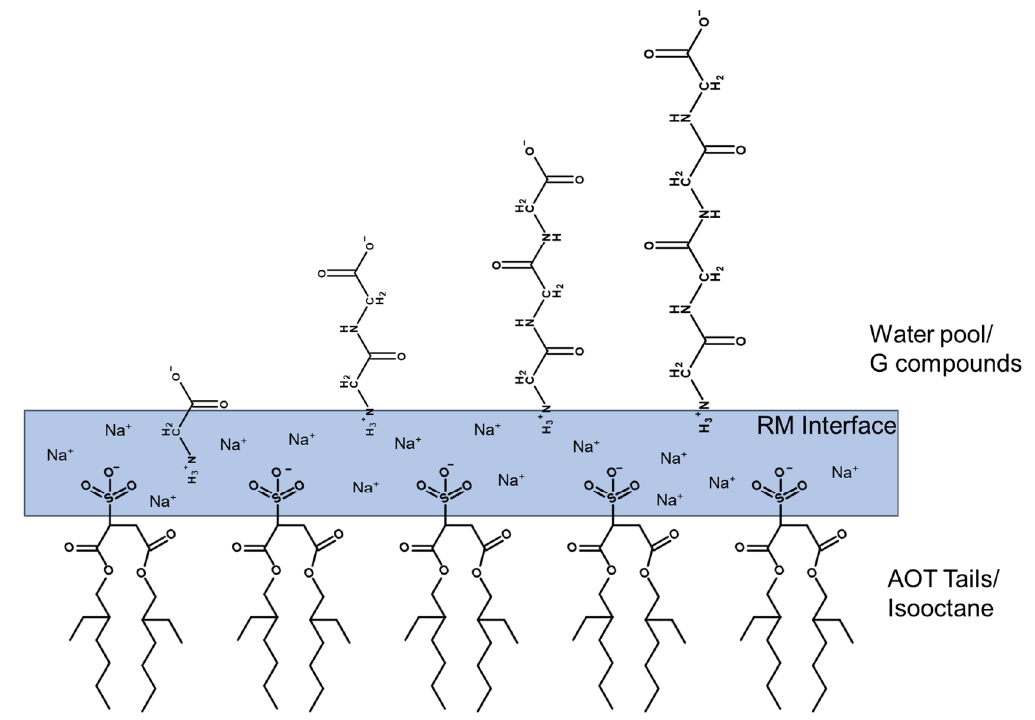
Figure 7. Schematic figure depicting the likely positioning of the G compounds used in this study relative to the RM interface. G compounds depicted here are shown in a linear conformation; however, it is likely that longer G compounds such as GGG and GGGG rotate around C-C bonds in solution such that the conformation of the molecule may be bent as discussed previously, but the C-terminal end is still located at the bulk water pool.